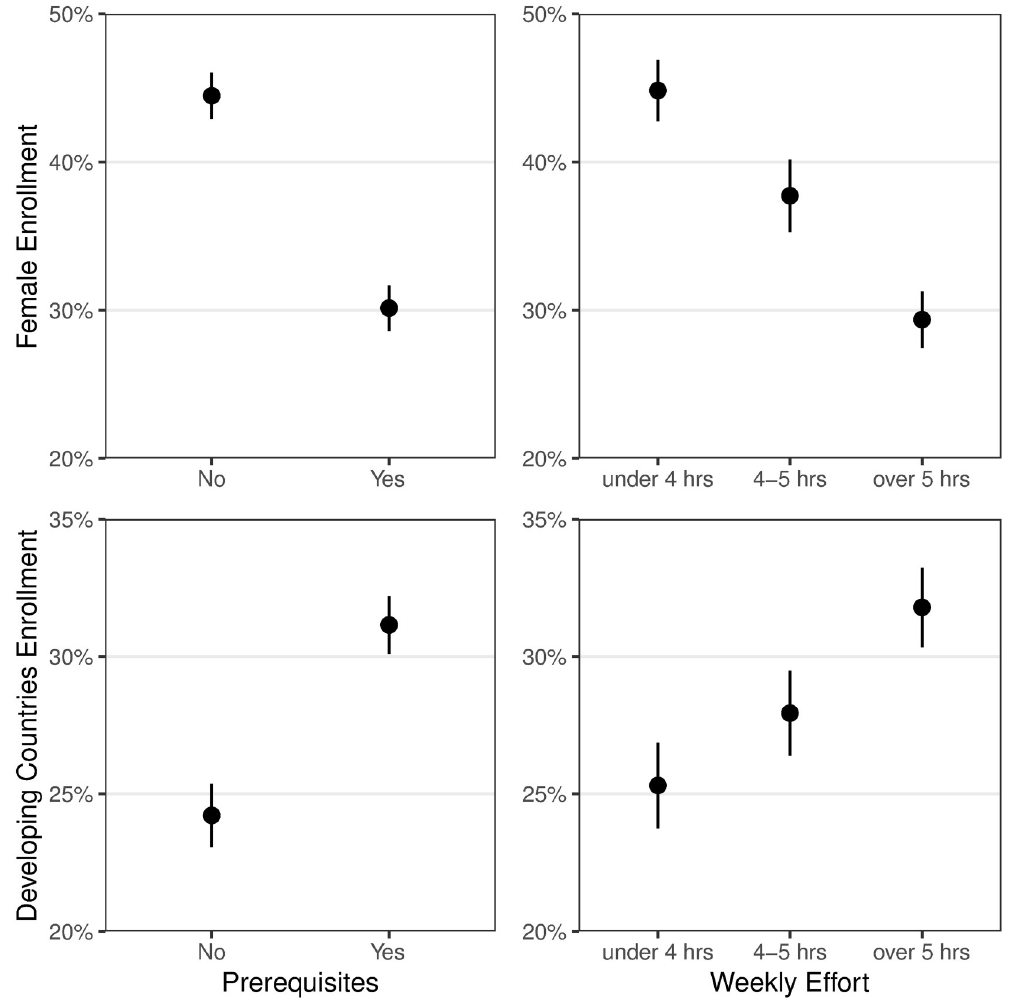
Fig 4. Female and low-HDI enrollment by prerequisites and weekly effort. Female enrollment (top panels) and enrollment from developing countries (bottom) varies with whether a course specifies prerequisites (left) and its expected amount of effort (right). Error bars show 1